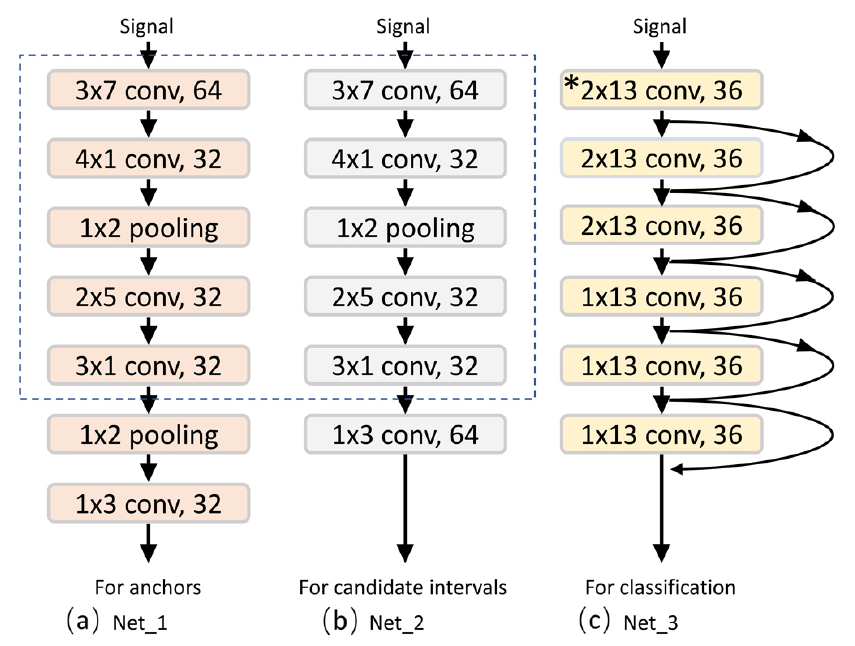
Figure 7. The architectures and configurations of the three networks used in this study. ( a ) Net_1 is used for interval generation in Section 3.1.1. ( b ) Net_2 is used for interval-based activity recognition in Section 3.1.2. ( c ) Net_3 is used for classification in Section 3.2.2. ∗ indicates that the stride of the layer